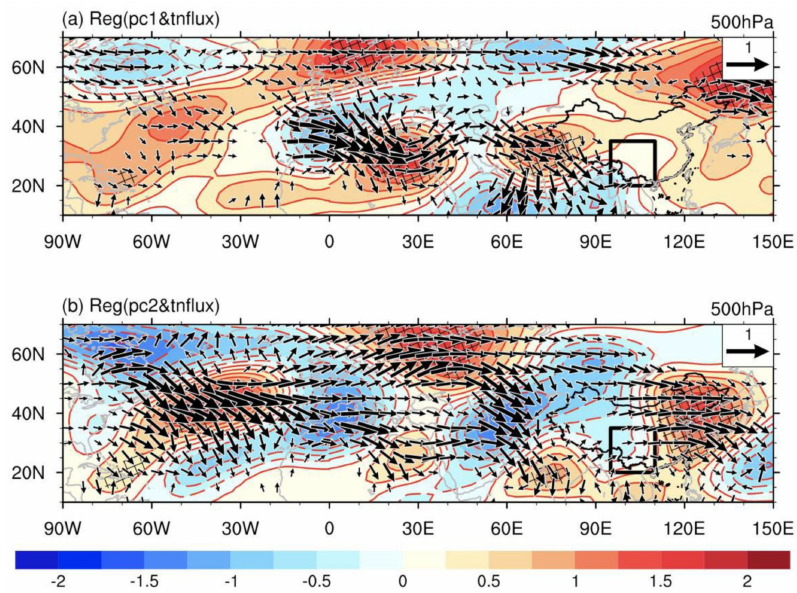
Figure 10. ( a ) Regressed anomalies of interannual components of wave activity flux (vectors, unit: m 2 s − 2 ) and stream function (shaded, unit: 10 6 m) at 500 hPa in late spring onto the interannual components of the PC1 for the period of 1960 to 2018. ( b ) As in ( a ), but for PC2. The black skew squares denote the values that have passed the 95% confidence level. The black squares represent the Southwest China (21 ◦ –33 ◦ N, 97 ◦ –110 ◦